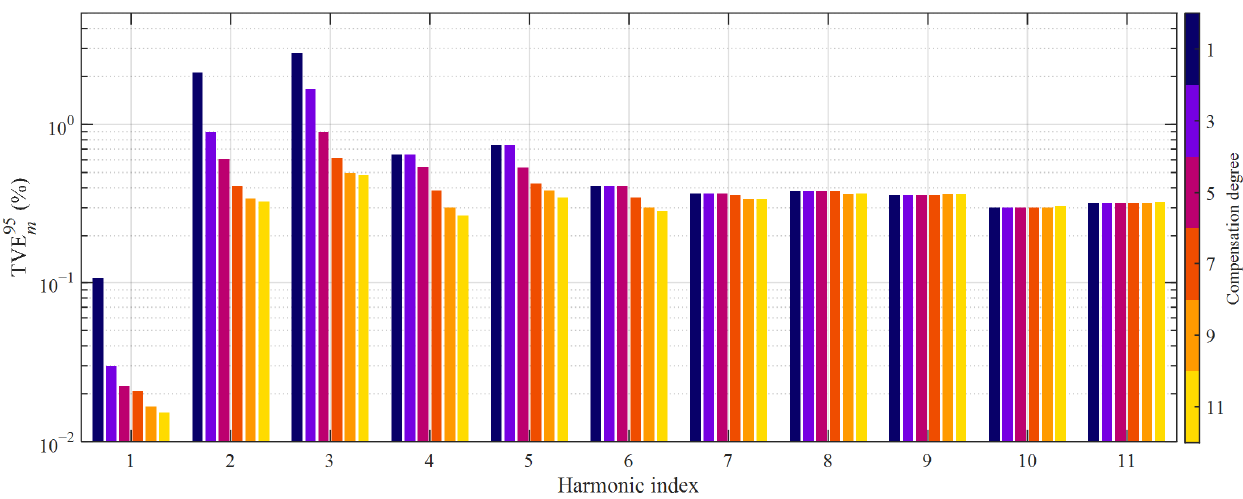
Figure 10. 95th percentile values of TVE achieved with HD compensation degrees from 1 to 11; transformer CT1, class E 2 of primary current waveforms.